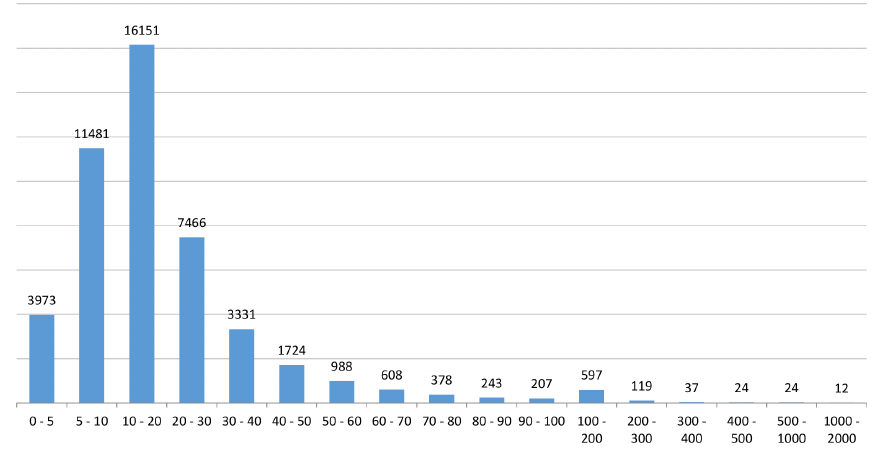
Figure 7. Distribution of AFEAD objects by length.